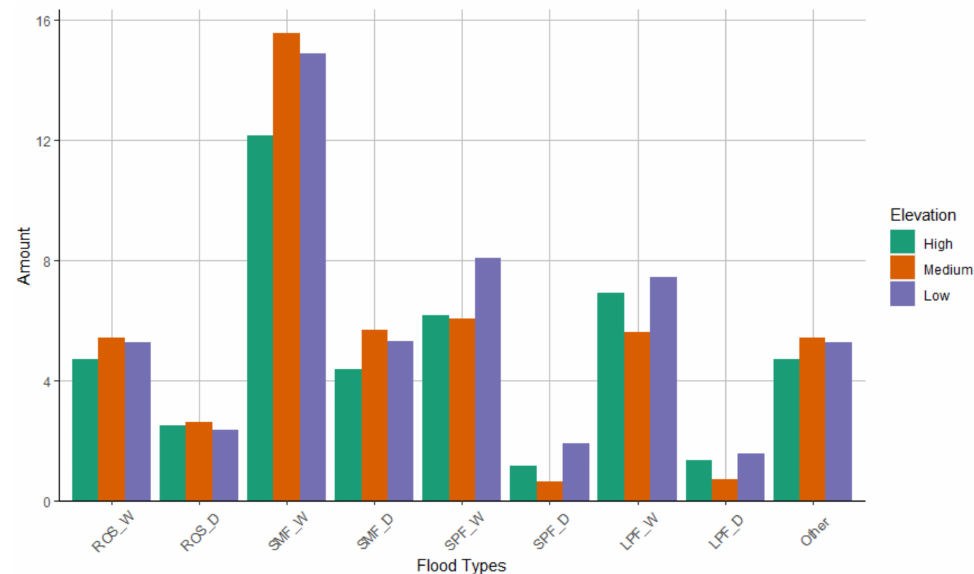
Figure 10. Flood typology classification based on the catchment